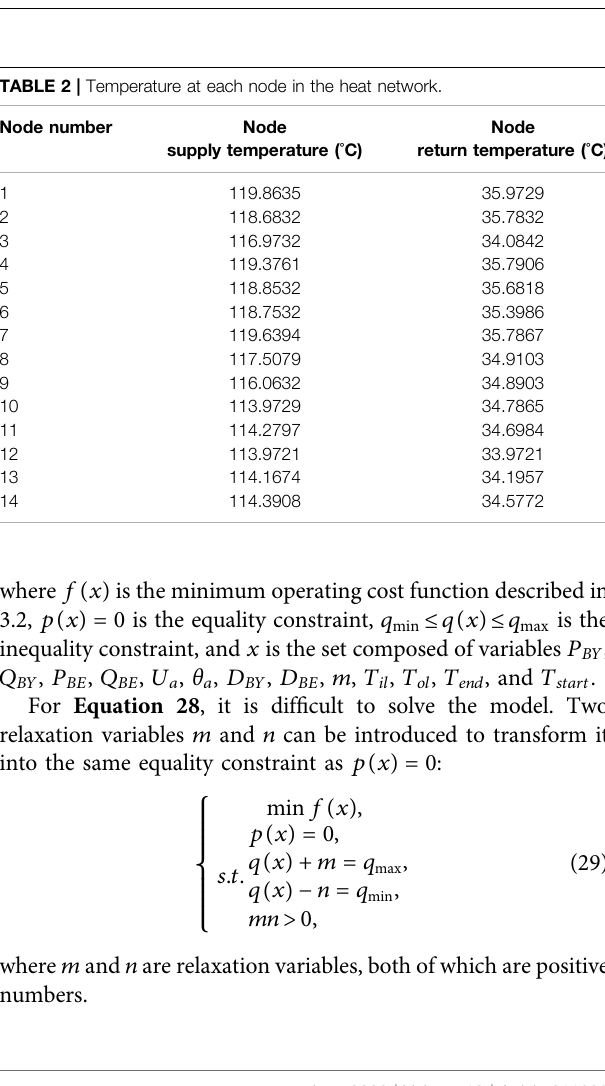
FIGURE 3 | Integrated energy testing system.